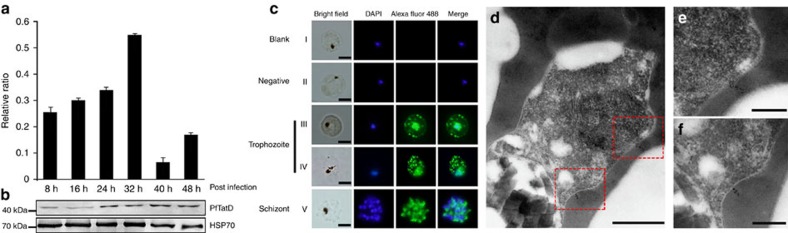
PfTatD is expressed at the mature stage of trophozoite-infected erythrocytes.(a) Transcriptional analysis of the PF3D7_0112000 gene was performed using quantitative PCR. Transcription was increased with parasite growth and reached its maximum at 32 h in the blood stage. The results are shown as the mean ±s.e.m. of 3 independent experiments. (b) An immunoblot was performed with rabbit anti-rPfTatD IgG (also see Supplementary Fig. 13). The top line indicates the expression of PfTatD every 8 h and the increased expression at 32 h in the blood stage. HSP70, presented in the bottom panel, was used as a control. (c) Indirect immunofluorescence of PfTatD was detected. The green fluorescence indicates that PfTatD was localized to the RBC membrane or the parasitophorous vacuole membrane of a mature trophozoite and was distinct from the nucleus in the schizont. The parasite nuclei were stained with DAPI. Scale bar, 5 μm. (d–f) Immune electron microscopy images of PfTatD. The gold particles were localized to the parasitophorous vacuole membrane, and there was a trend for localization to the periphery. Scale bar, (d) 500 nm and (e,f) 200 nm.